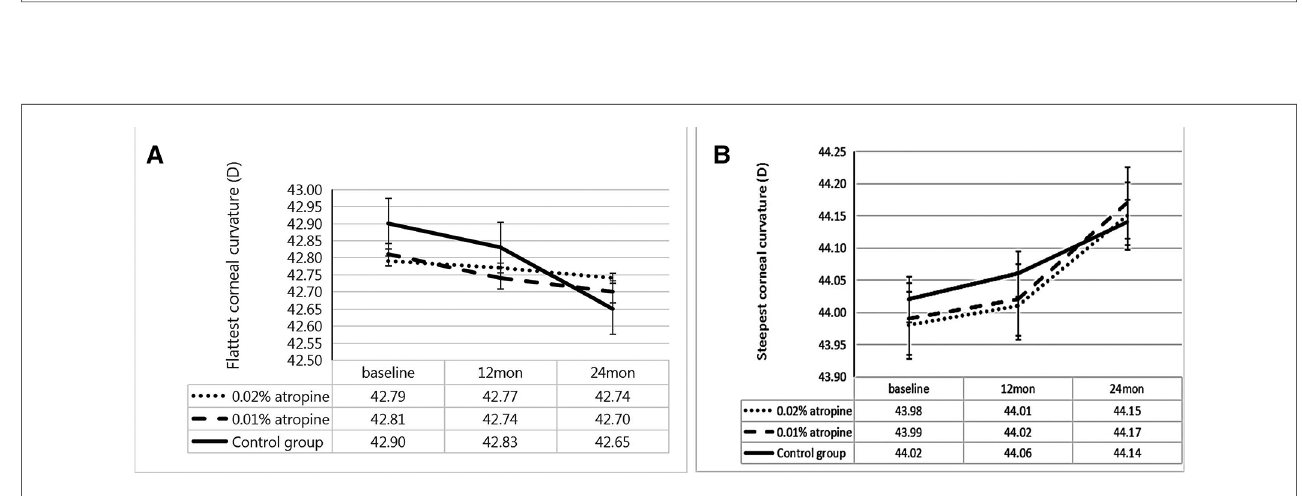
FIGURE 3 Measurement of intraocular pressure ( A ) and anterior chamber depth ( B ) and lens power ( C ) over time.